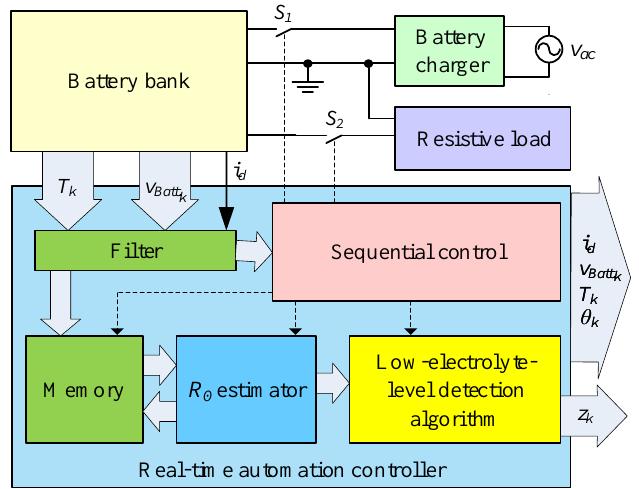
Figure 8. Block diagram of the implemented